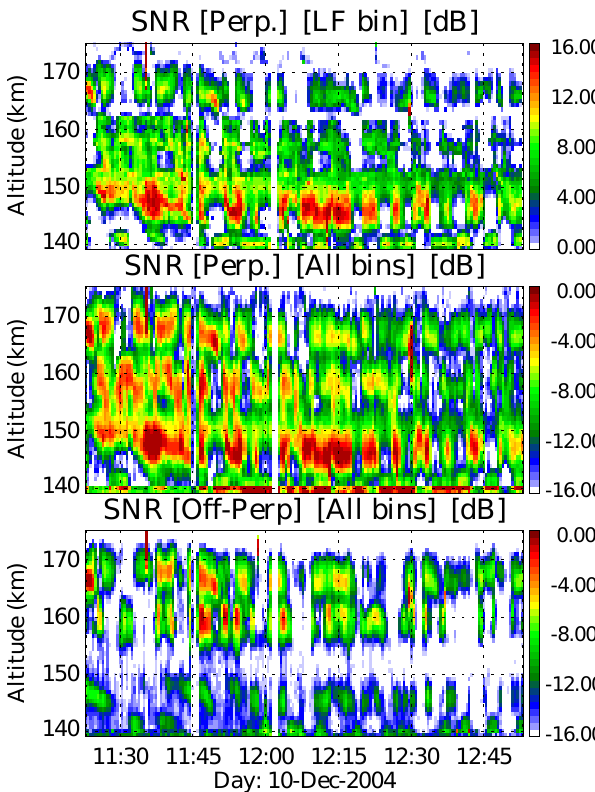
Fig. 2. Signal-to-noise ratio (SNR) contour plots for the two beam experiment conducted on 10 December 2004. (a) The low fre- quency (LF) component of the perpendicular beam after coherent integration, (b) using all the frequency bins for the perpendicular signal, and (c) the off-perpendicular signal using all frequency bins. The values are color coded with the color bar at the right of each plot.